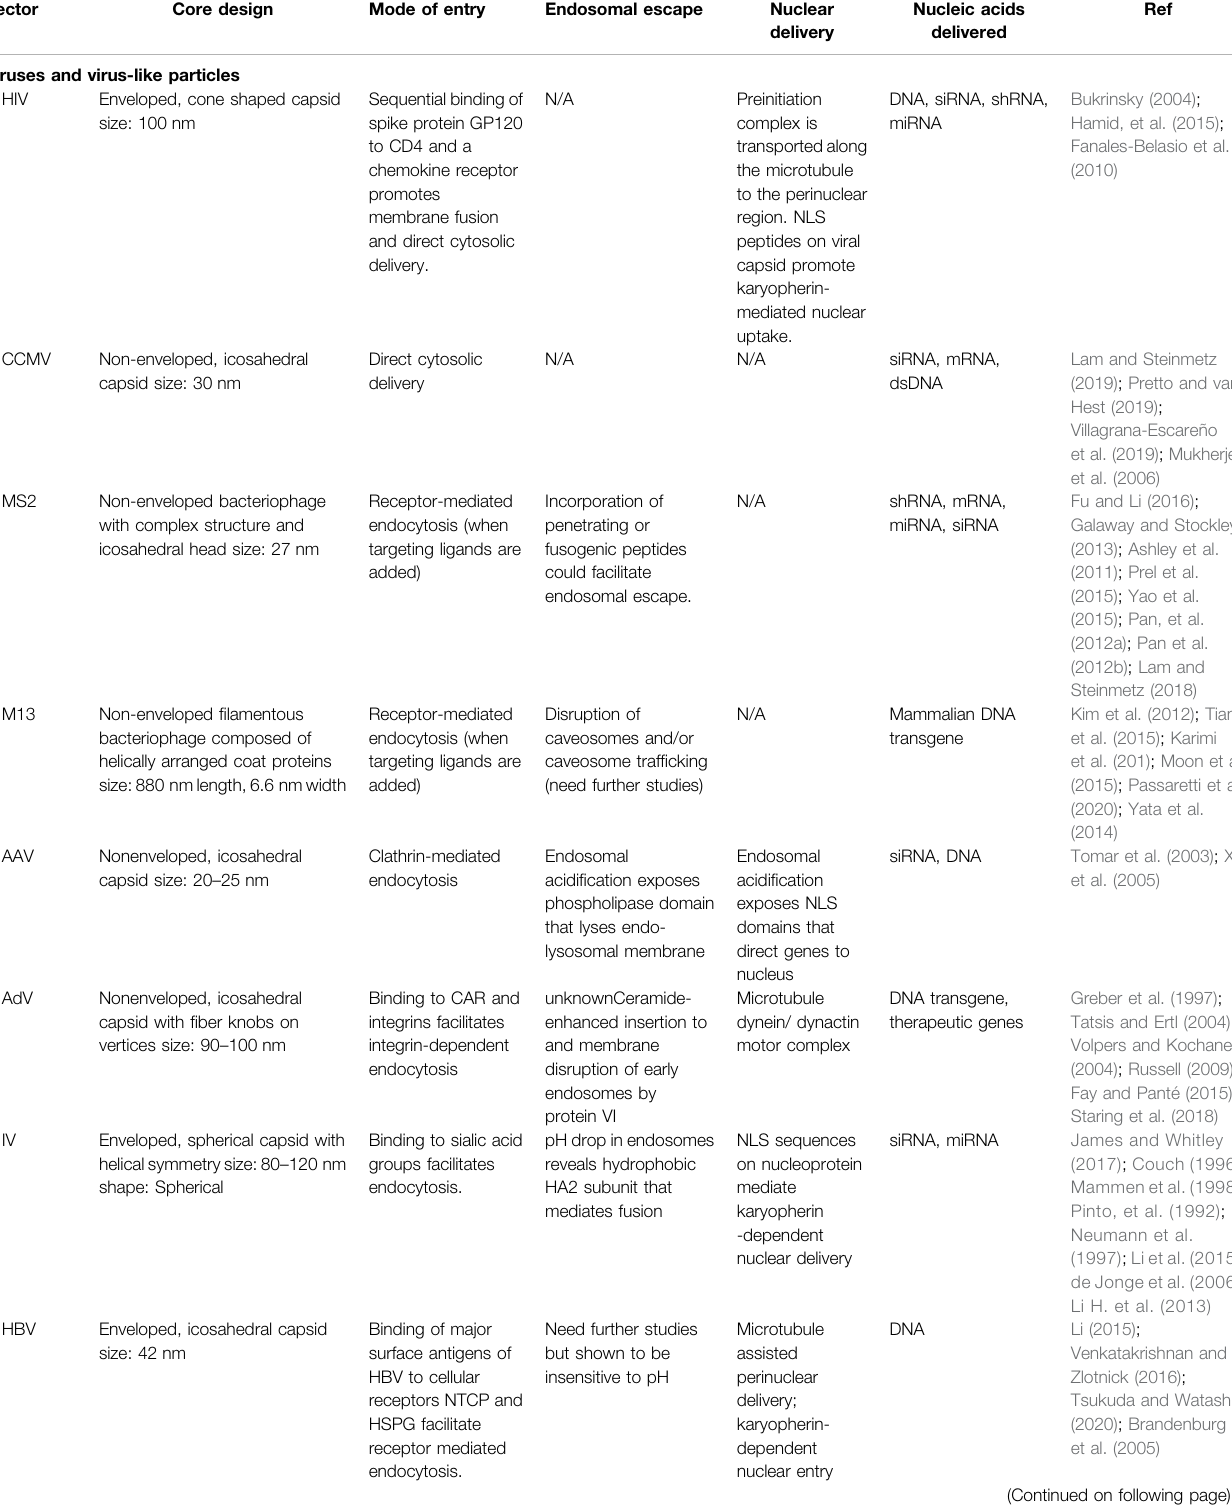
TABLE 1 | Nucleic acid carriers: Properties and traf fi cking.